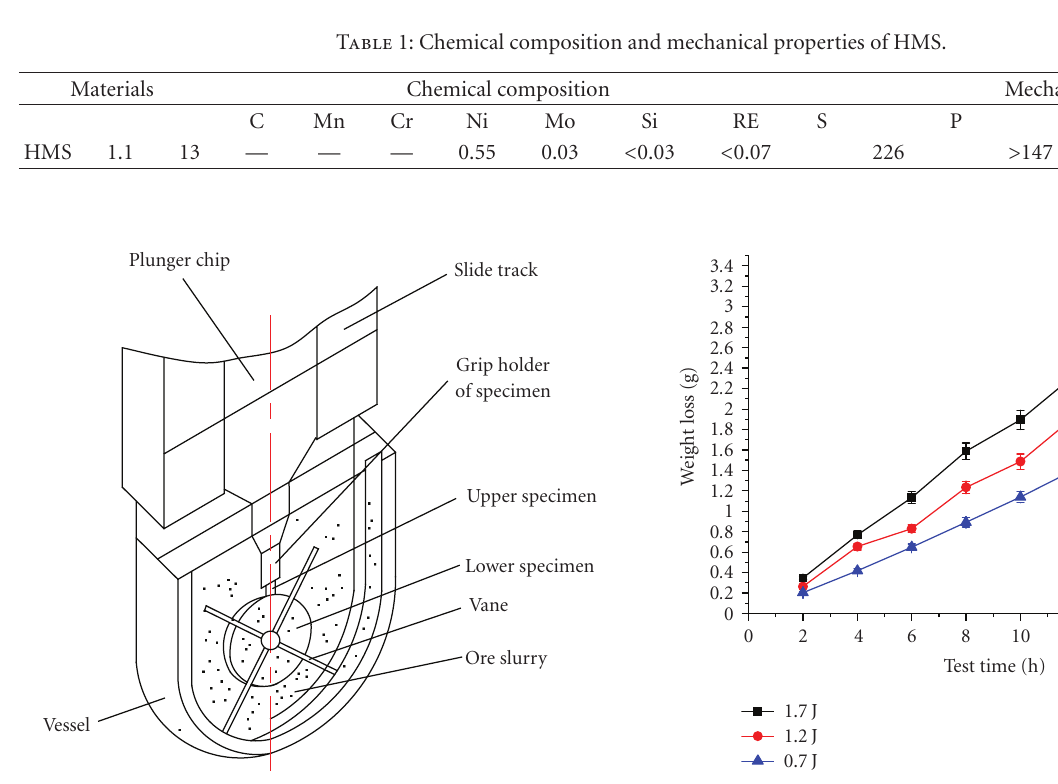
Figure 2: Relation between the wear loss and wear time of the HMS in acid-ironstone slurry at di ff erent impact